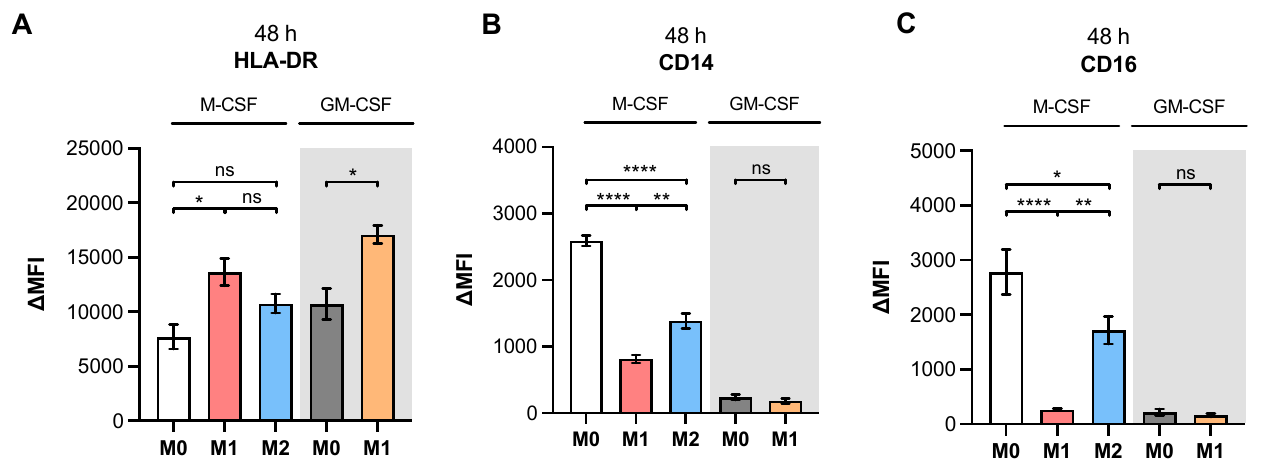
Negatively selected monocytes were differentiated to macrophages using M-CSF or GM-CSF (highlighted in grey). After 6 days, M Φ were stimulated with IFN- γ /LPS (M1), IL-4 (M2), or with no additive (M0). Cells were analyzed using flow cytometry, after a polarization time of 48 h. The arithmetic mean fluorescence intensity (MFI) was measured for the markers ( A ) HLA-DR, ( B ) CD14 and ( C ) CD16, and the MFI of unstained cells was subtracted ( ∆ MFI). The data from independent donor-derived primary macrophage cultures (n, sample = 3) were analyzed using a one-way